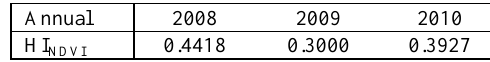
Table 1. The Harvest Index(HI) of wheat in 2008-2010a